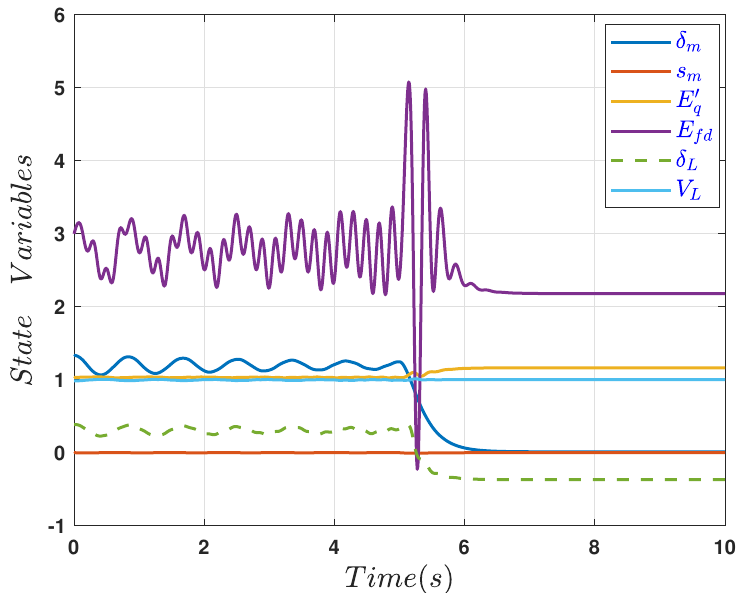
Figure 6. Controlled system (12) state variables time series with control in action at t = 5 ( s ).